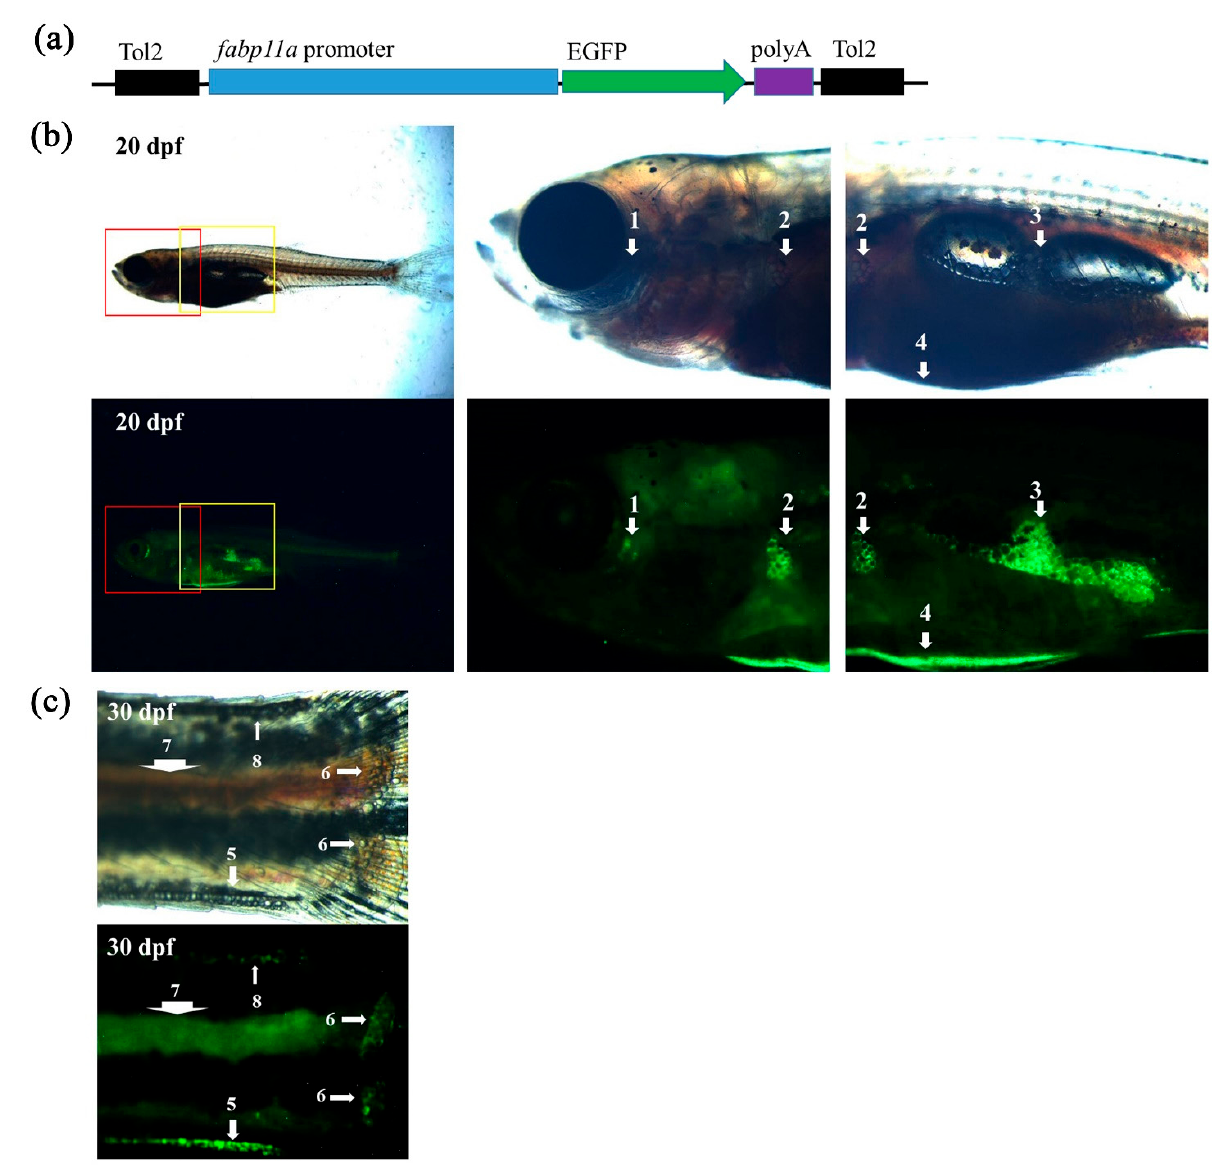
Figure 1. Visualization of adipose tissues in transgenic zebrafish. ( a ) Schematic drawing of the DNA construct used to generate the zebrafish transgenic line, Tg ( fabp11a : EGFP). ( b ) Overview of a Tg ( fabp11a : EGFP) at 20 dpf and zoom-in views of the boxed areas. Numbers denote adipose depots; 1, OCUAT (ocular adipose tissue); 2, PECSAT (pectoral fin subcutaneous adipose tissue); 3, VAT (visceral adipose tissue); and 4, ASAT (abdominal subcutaneous adipose tissue). ( c ) Imaging of a Tg ( fabp11a : EGFP) zebrafish tail at 30 dpf. 5, VSAT (ventral subcutaneous adipose tissue); 6, CFRSAT (caudal fin ray subcutaneous adipose tissue); 7, POSAT (paraosseal adipose tissue); and 8, DSAT (dorsal subcutaneous adipose